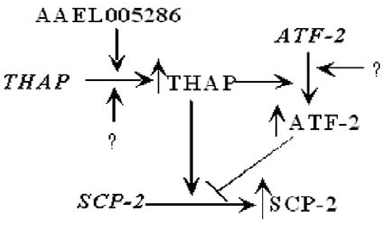
Figure 7. Schematic diagram showing THAP- and ATF-2- regulated AeSCP-2 expression in the midgut of feeding 4 th instar larvae. Arrows indicate up regulation, bar represents down regulation, ‘‘?’’ denotes unknown